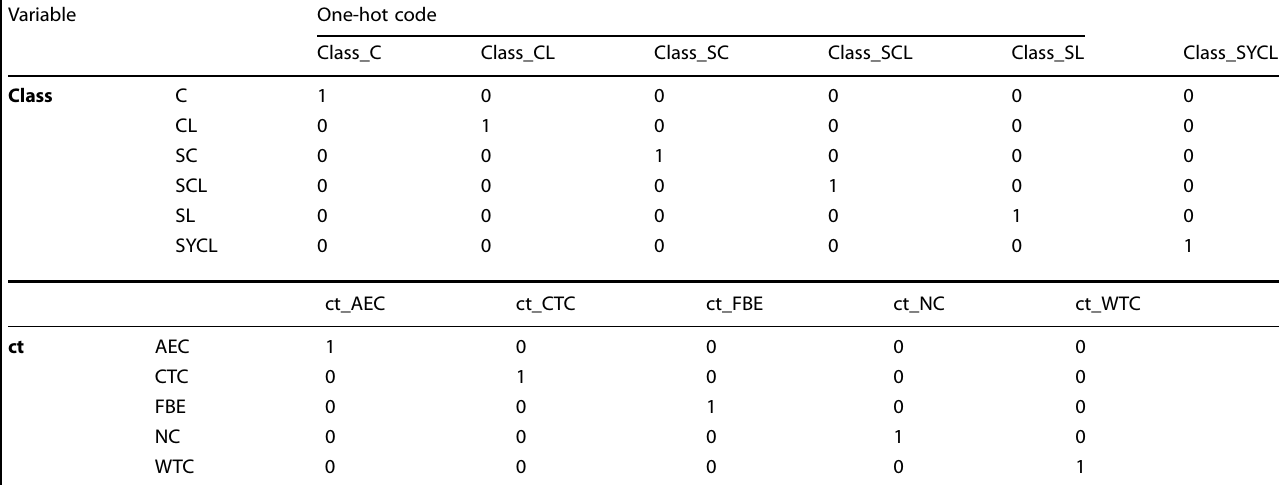
Table 2. One-hot encoding of coating and soil type.